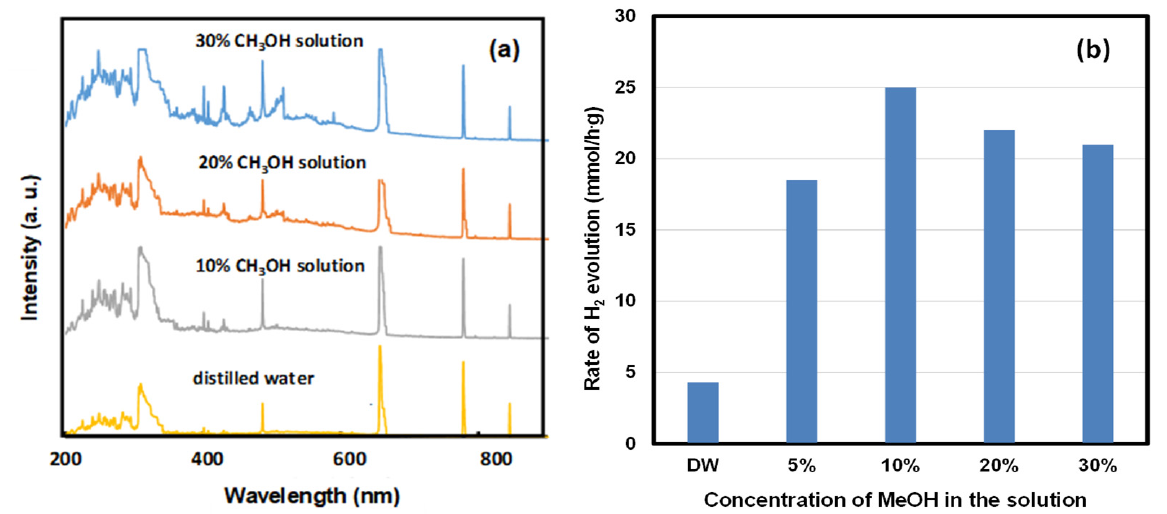
Figure 7. ( a ) OES spectra by LPP discharge and ( b ) HER of BF in an aqueous methanol solution with different concentrations.